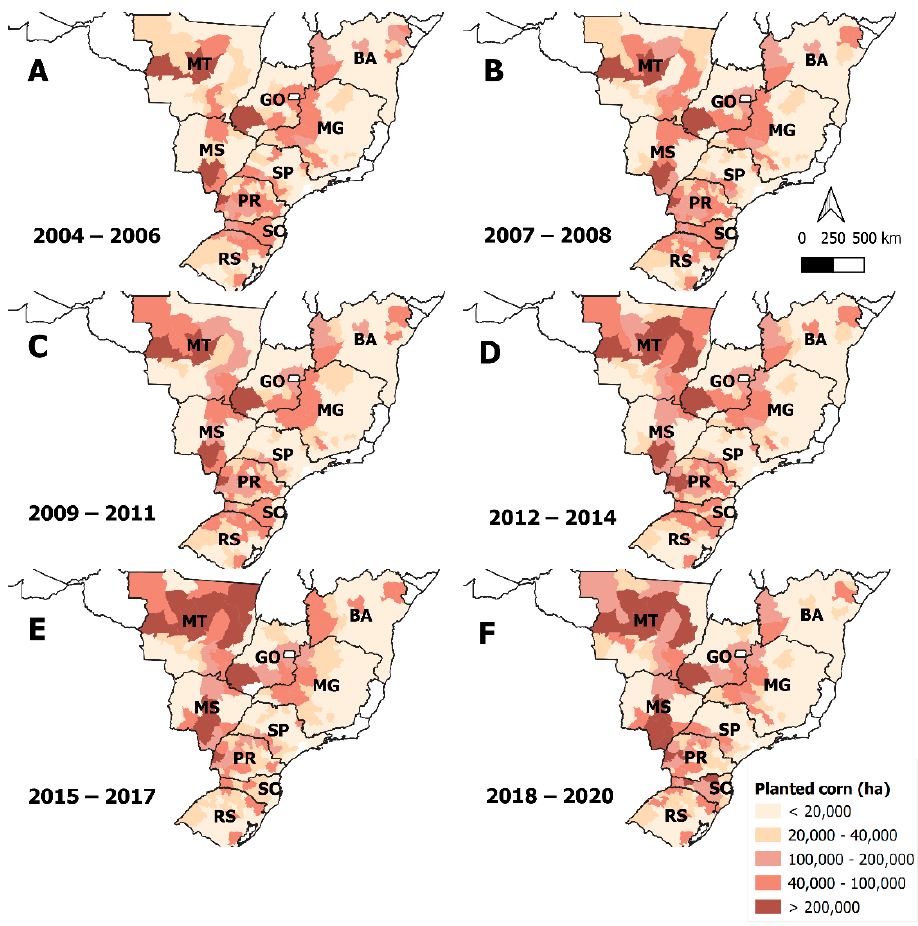
Figure 4. Maps showing cultivated corn areas across main corn-growing areas in Brazil. Cultivated area in each map is the mean value for the years considered in each map. Database used to build the maps can be found at this URL: https://www.ibge.gov.br/estatisticas/economicas/agricultura- e-pecuaria/9117-producao-agricola-municipal-culturas-temporarias-e-permanentes.html?=&t= destaques, accessed on 10 November